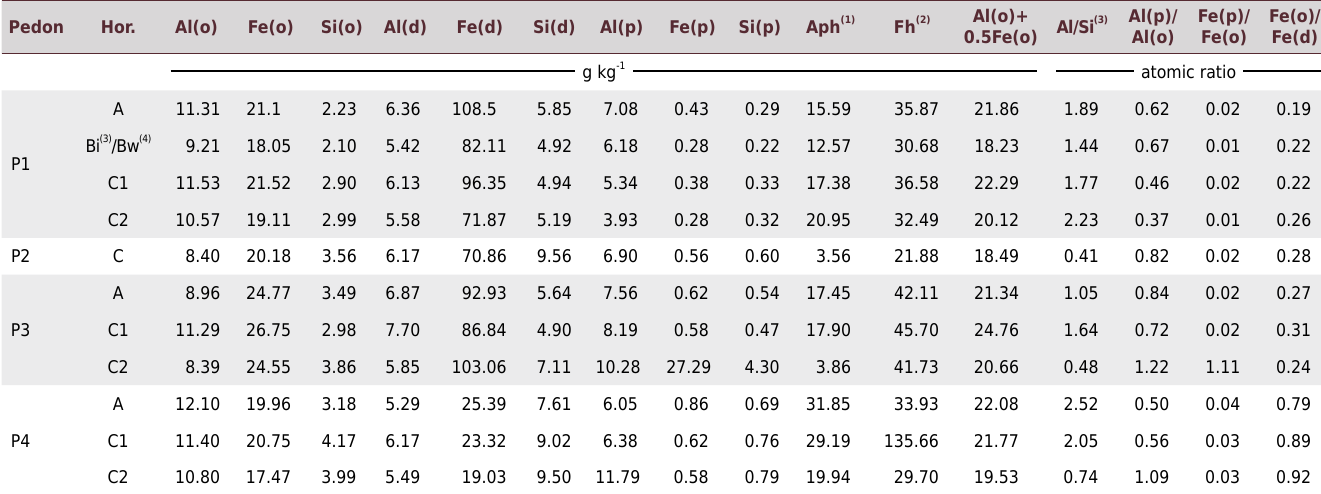
Table 3. Selective dissolution and mineralogical properties of TI soils Pedon